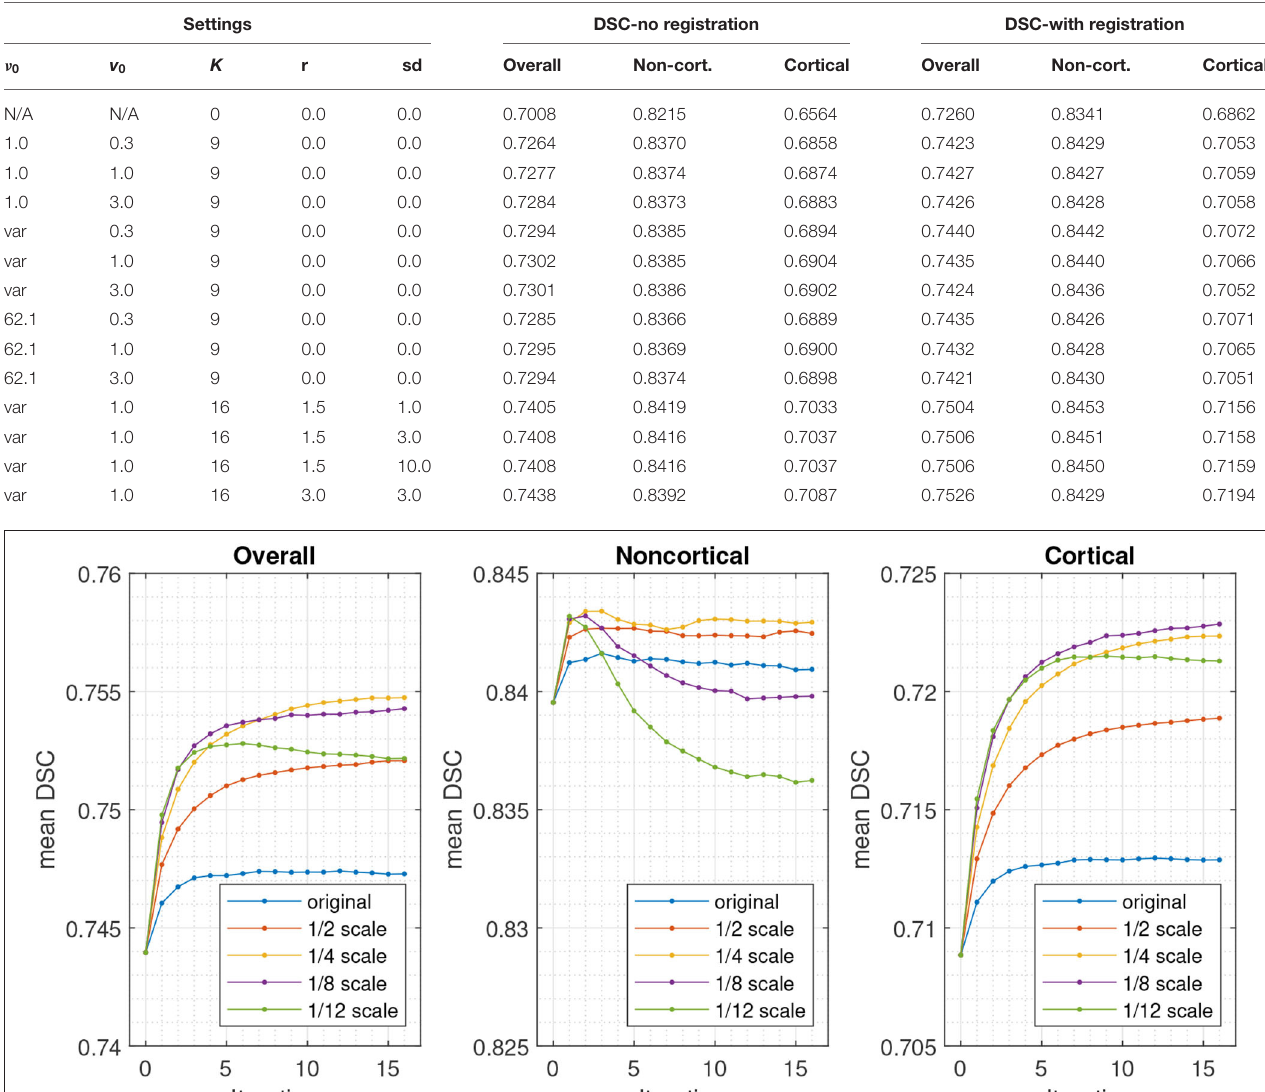
TABLE 1 | Training/validation DSC with different settings.